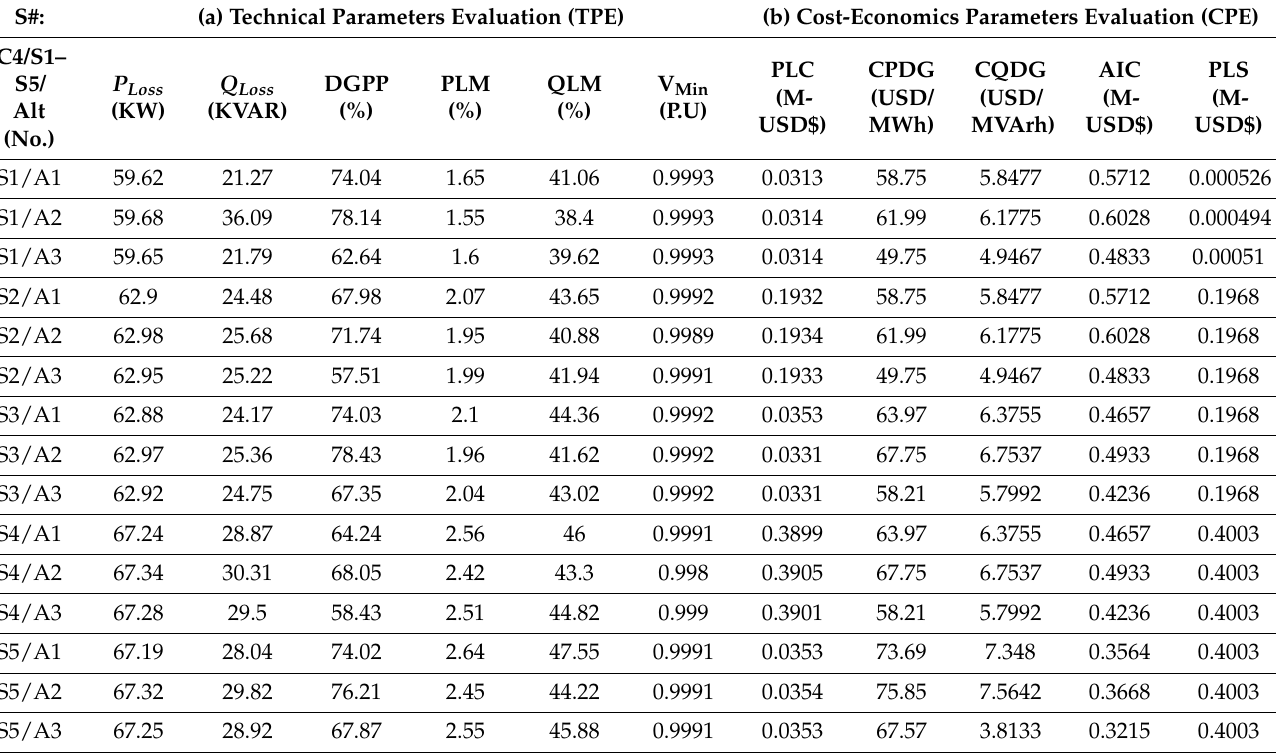
Table 18. TPE/CPE evaluations in C4/S1–S5 for the 65-bus MCMG (NUST_MG) for DG + DSTATCOM.